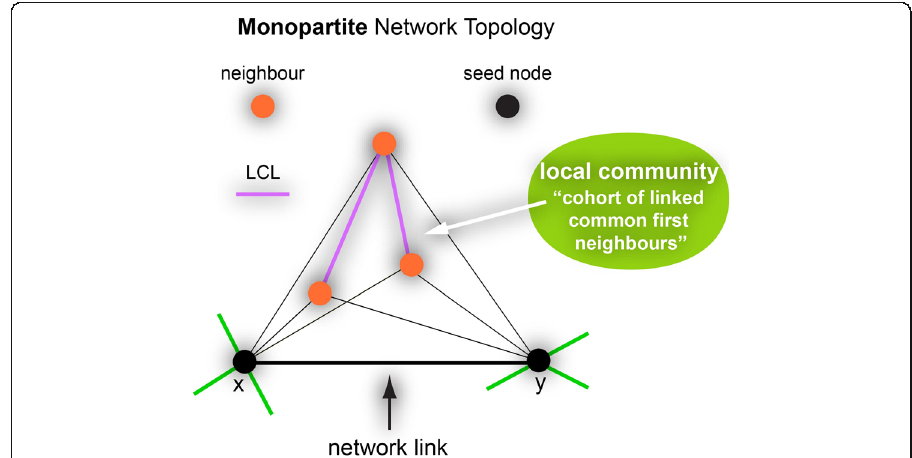
Fig. 2 The figure is a visual representation of the LCP-theory proposed to model local-topology-dependent link-growth in complex networks. Let ’ s focus on a network link between two seed nodes X and Y ( black ). Nodes that are first-level neighbours of the seed nodes and that are shared between them represent their common neighbours ( CN, orange ). In green are shown links to first-level neighbours that are not shared. The cohort of the CNs together with their cross-interactions, named local community links ( LCL, purple ), form a local community. According to the LCP-theory , in many complex networks there is a high positive correlation between the number of CNs and the number of the corresponding LCLs for each link in the network, and both the information should be exploited in order to explain the local-topology-based emergence of links in the network that is named epitopological